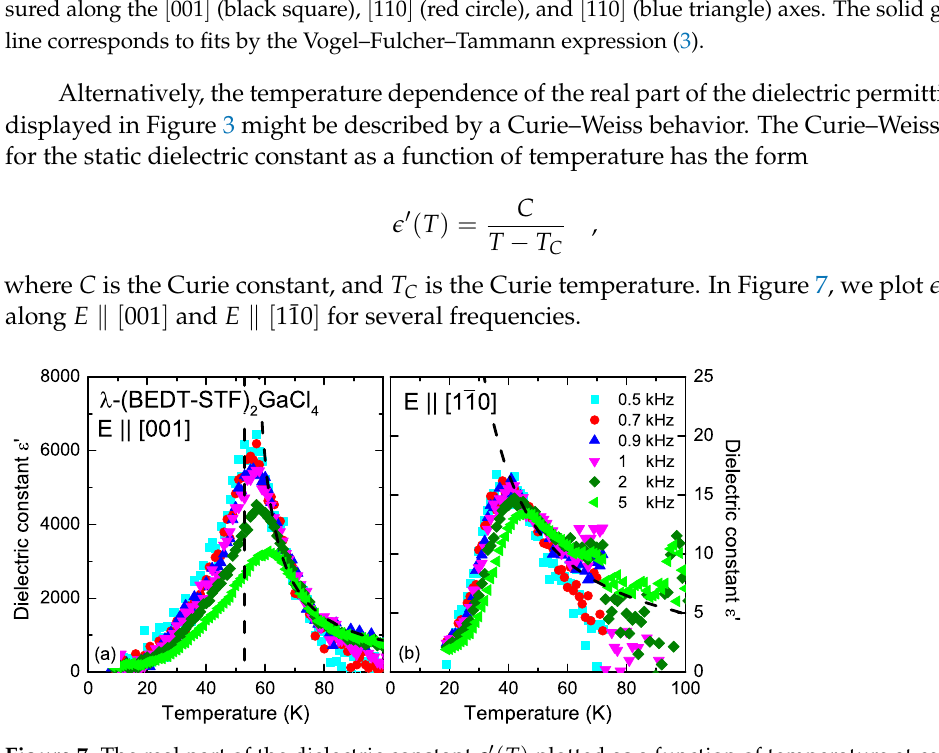
Figure 7. The real part of the dielectric constant (cid:101) (cid:48) ( T ) plotted as a function of temperature at certain frequencies for ( a ) E (cid:107) [ 001 ] and ( b ) E (cid:107) [ 1¯10 ] . The dashed black line corresponds to the Curie–Weiss fit according to Equation